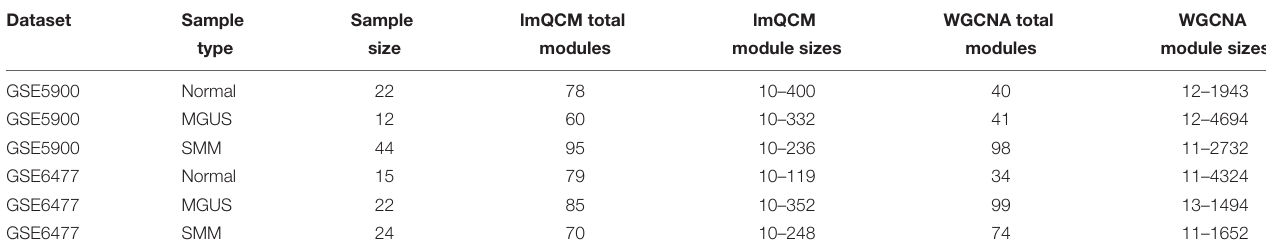
TABLE 1 | GCN results from algorithms lmQCM and